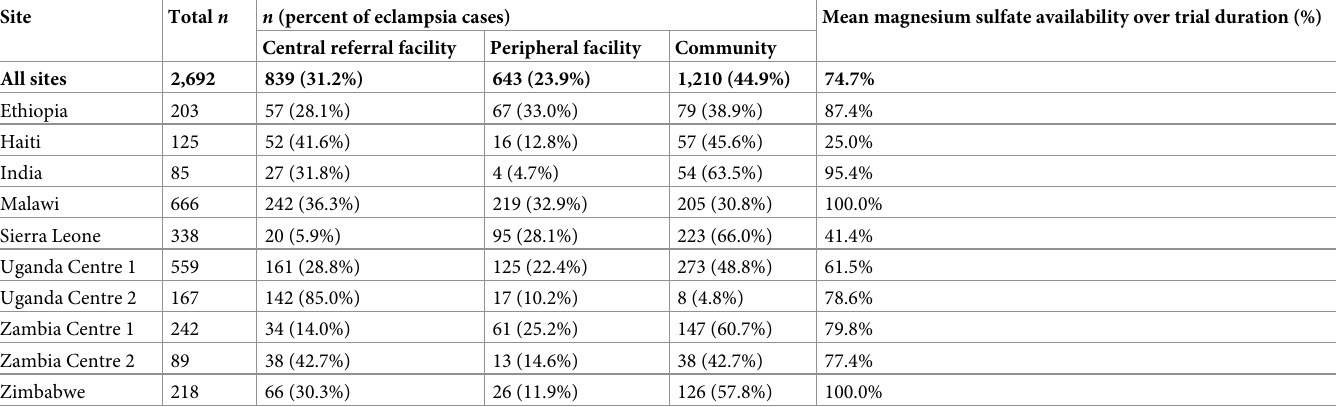
Table 2. Place of eclamptic fit and proportion of facilities with magnesium sulfate available on average over trial duration.